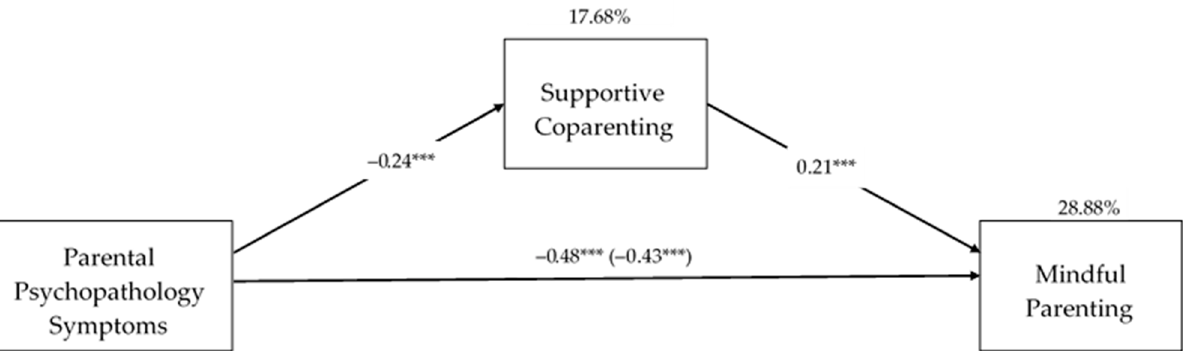
Figure 1. Statistical diagram of the simple mediation model between parental psychopathology symptoms and mindful parenting through supportive coparenting. *** p < 0.001. Note : The values of the trajectories represent the standardized regression coefficients. In the arrow that links parental psychopathology symptomatology to mindful parenting, the value outside the parentheses represents the total effect of parental psychopathology symptomatology on mindful parenting. The value within the parentheses represents the direct effect of parental psychopathology symptomatology on mindful parenting after the inclusion of supportive coparenting.